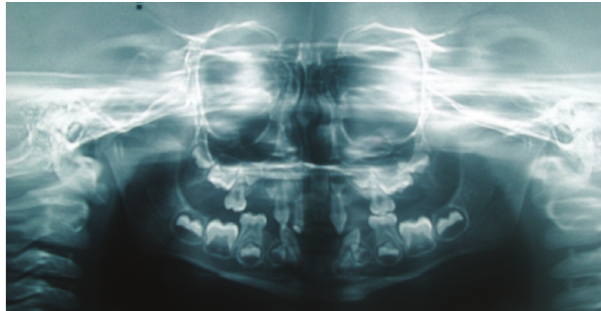
Figure2:Panoramicradiographyrevealedthecongenitalabsenceof all deciduous first molars, lateral incisors, and lower central incisors; absence of germs in all first premolars, lateral incisors, and lower central incisors; and morphological alterations in deciduous canines and second